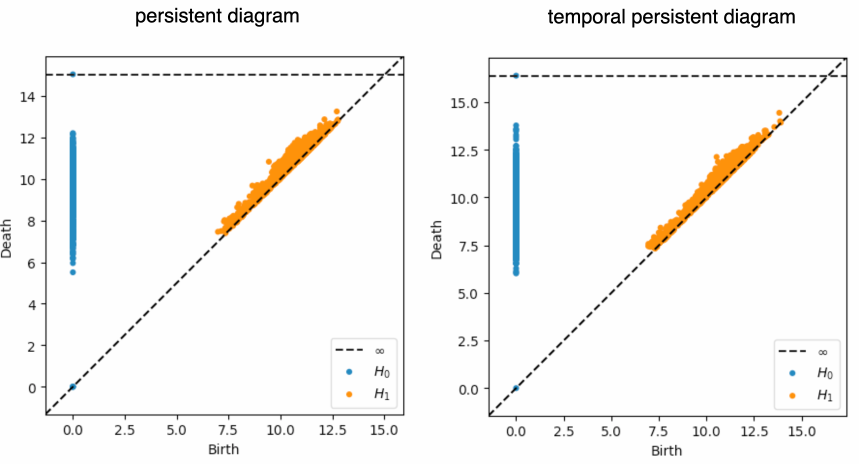
Figure 6. Persistence diagrams. The persistence diagrams computed from the persistent homology and temporal persistent homology are shown here. The x-axis corresponds to the birth of all the persistent modules arising in the filtration process, and the y-axis corresponds to their death.